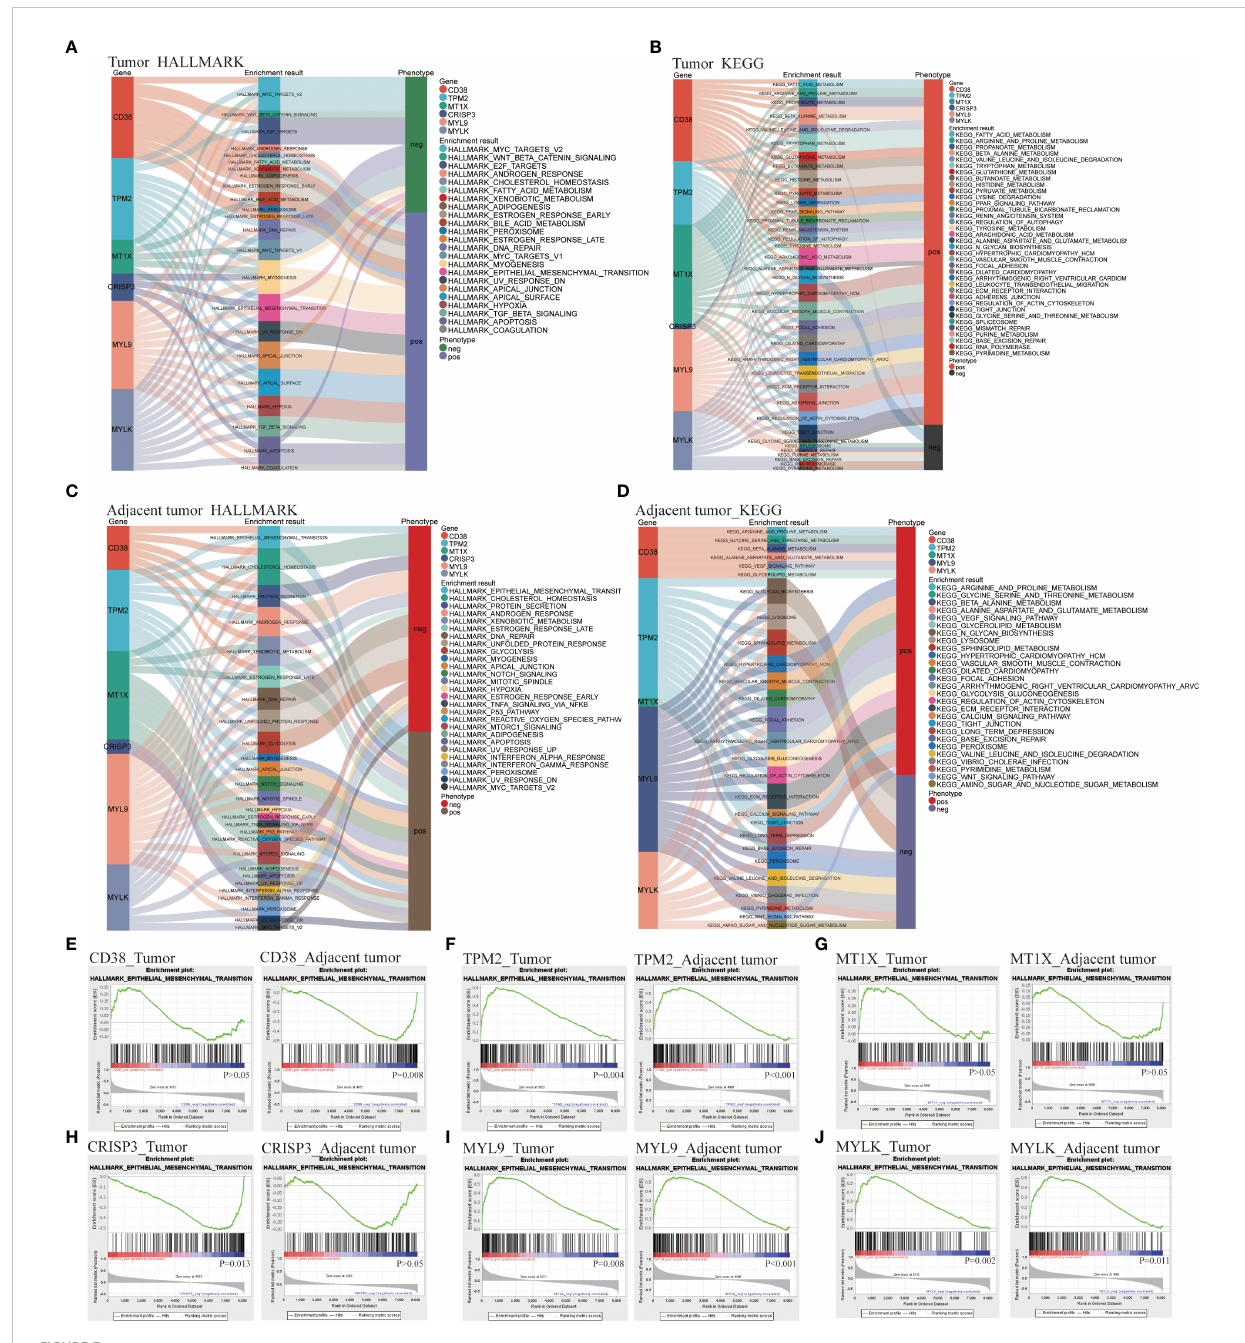
FIGURE 3 LDEGs functional analyses. (A, B) HALLMARK and KEGG enrichment analysis of LRHG in tumor. (C, D) . HALLMARK and KEGG enrichment analysis of LRHG in adjacent normal; (E – J) . The enrichment results of LRHG in EMT